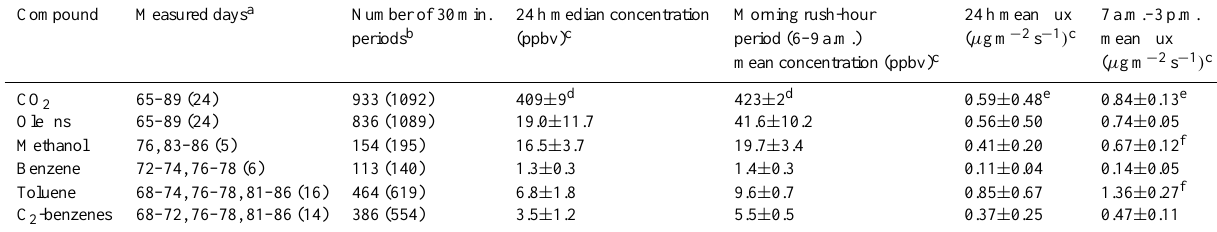
a Days of the year when measurements were performed. Numbers in parenthesis indicate the number of measured days. b Number of periods in which the flux quality criteria were met. Numbers in parenthesis correspond to the total number of 30min periods measured. c The numbers at the right of the ± symbol indicate one standard deviation. d Units in